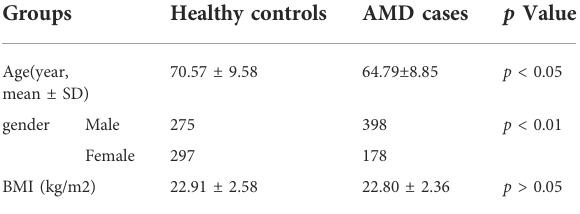
TABLE 1 Basic Information of the